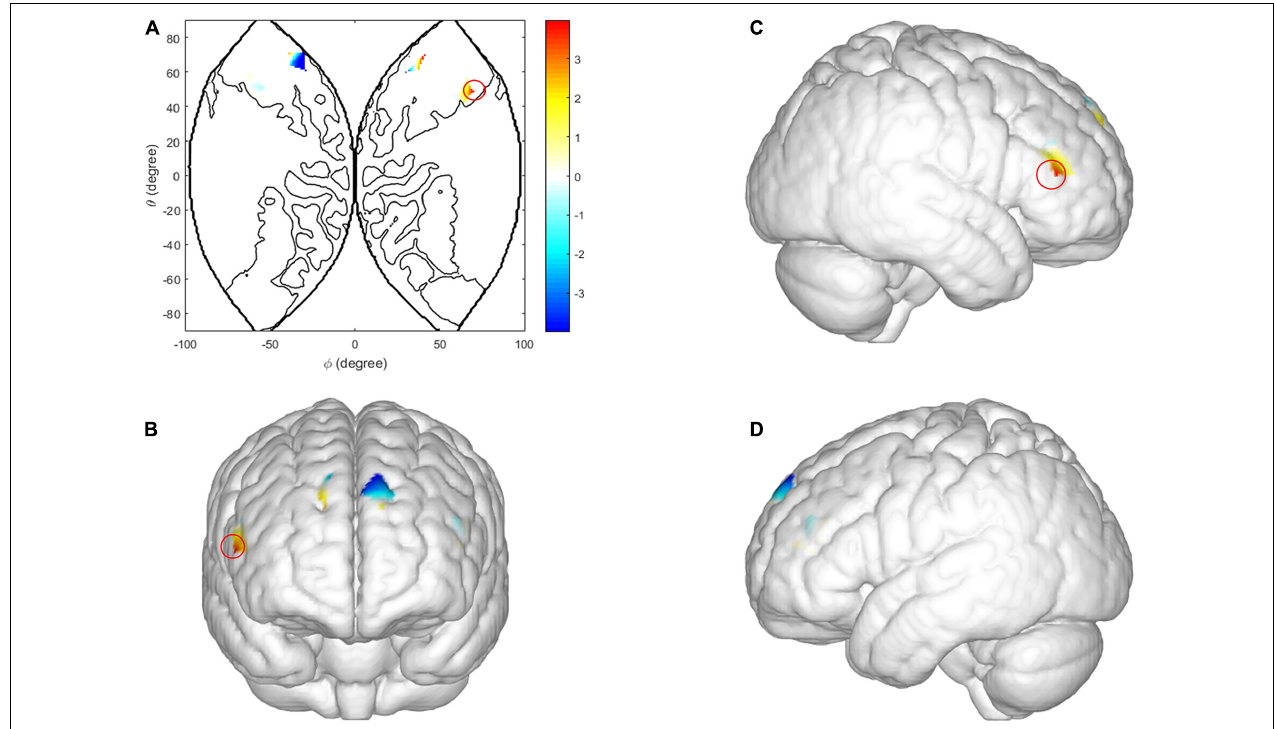
FIGURE 6 | Inter brain synchronization in TCDM stage. (A–D) Higher INS values in the right IFG (HIR condition vs. LIR condition). (A) The 2D model of INS values of the right IFG; (B) front, (C) right, and (D) left view of a 3D model of INS values of the right IFG.